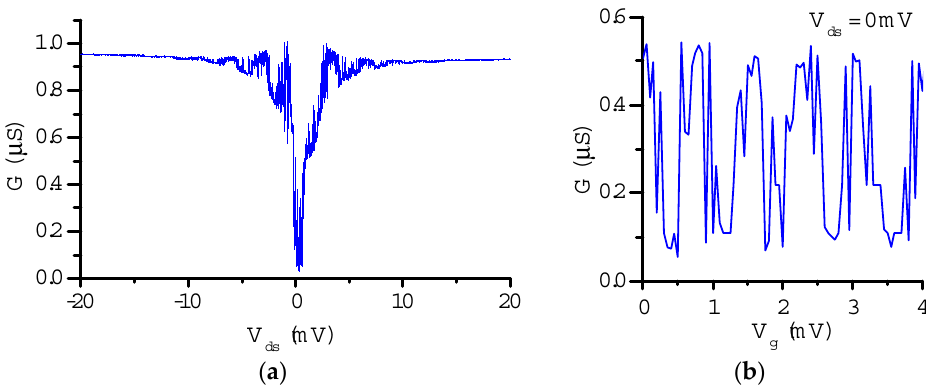
Figure 10. ( a ) Typical G ( V ds ) dependence observed in samples fabricated with two FGA steps; T = 0.4 K. The metal is Ni and the barrier composition is six cycles of ALD SiO 2 (~0.7 nm) and four cycles of ALD Al 2 O 3 (~0.4 nm) so the total barrier thickness is ~1.1 nm; ( b ) G ( V g ) dependence for the same SET, showing the excess switching noise.